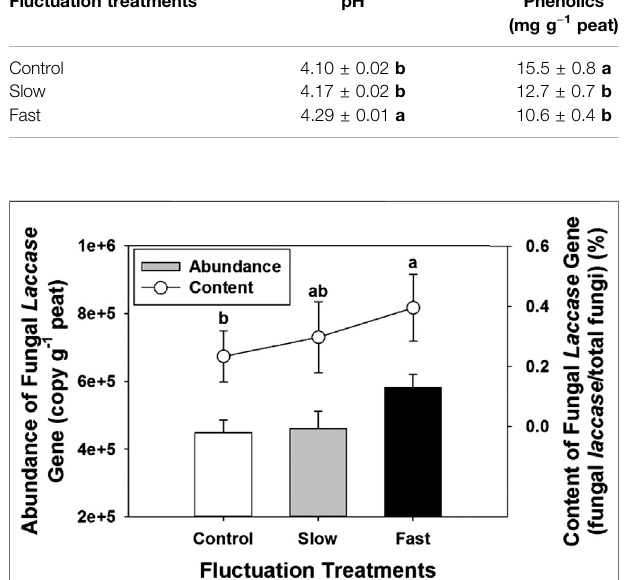
FIGURE 5 | Abundance of fungal laccase gene (bar) and content of fungal laccase gene to the total fungi (line) in peat. Error bars denote standard errors. Letter denotes statistically signi fi cant differences between treatments (n (cid:2) 24, p < 0.05).